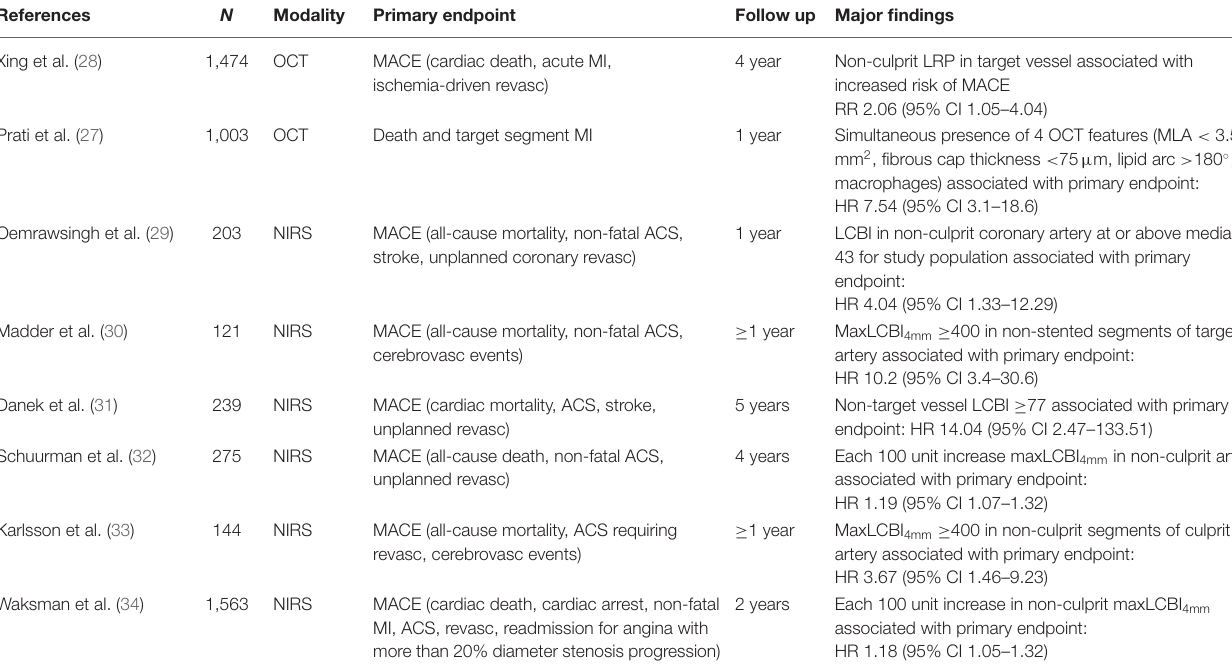
TABLE 2 | Summary of OCT and NIRS studies for the detection of vulnerable patients.